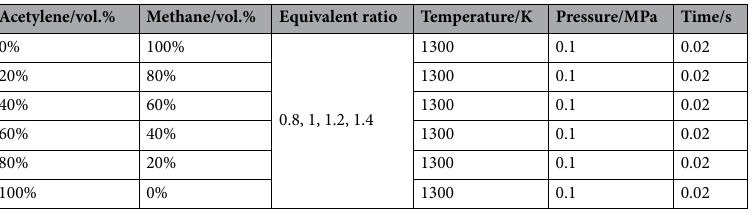
Table 1. Initial